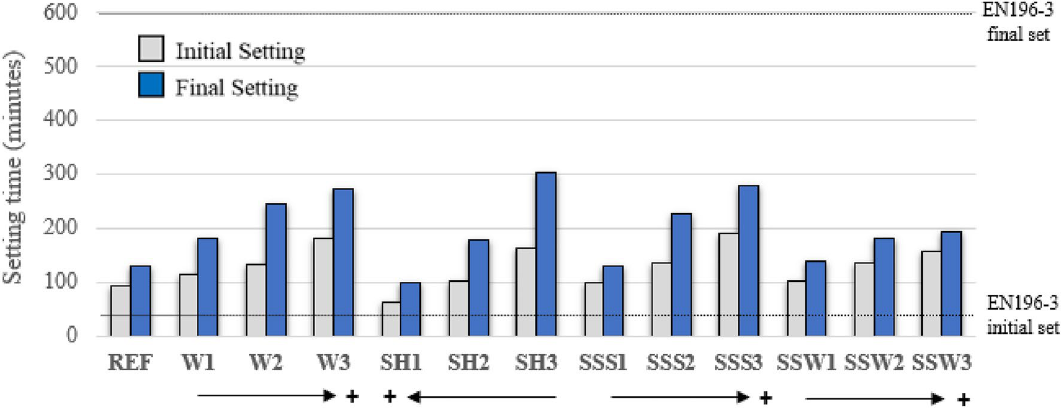
Fig. 3 Initial and final setting time of the different metakaolin geopolymer formulations. The (+) and ( → ) indicate the gradual reagent increase of each